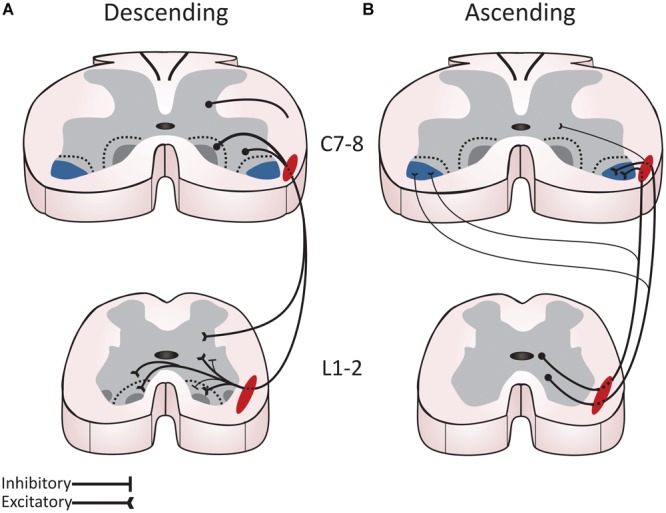
Long propriospinal interneurons (PINs) reciprocally connect the cervical and lumbar spinal cord and contribute to locomotor movement in rodents. (A) Descending PINs form a complex bilateral system with excitatory and inhibitory components to mediate interlimb coordination and to relate information to the CPG. Their cell body is located through all laminae of the cervical cord, but most originate from laminae VII-VIII and the deep dorsal horn. They project to non-motoneuronal elements in similar proportion to the ipsilateral and contralateral rostral lumbar cord through the ventrolateral funiculus (red). The ipsilateral population terminals are evenly distributed throughout the gray matter, whereas the projections of the contralateral population are concentrated in laminae VII-VIII. The vast majority of descending PINs are excitatory both on the ipsilateral or contralateral side but the small inhibitory population terminates ipsilaterally. (B) Ascending PINs form a powerful ipsilateral excitatory pathway from the rostral lumbar cord to motoneurons controlling proximal muscles of the forelimbs. Ascending PINs originate mostly from the intermediate gray in the lumbar spinal cord and preferentially project ipsilaterally with a very limited number of terminals found contralaterally. They project to the intermediate gray matter and the ventral horn throughout the length of the cervical spinal cord. However, a large proportion directly connects to motoneurons in ventrolateral motor nuclei (blue) in caudal cervical segments controlling muscles of the elbow and shoulder. The thickness of the lines represents more PINS. Figure adapted and modified from Flynn et al. (2011) and Brockett et al. (2013).